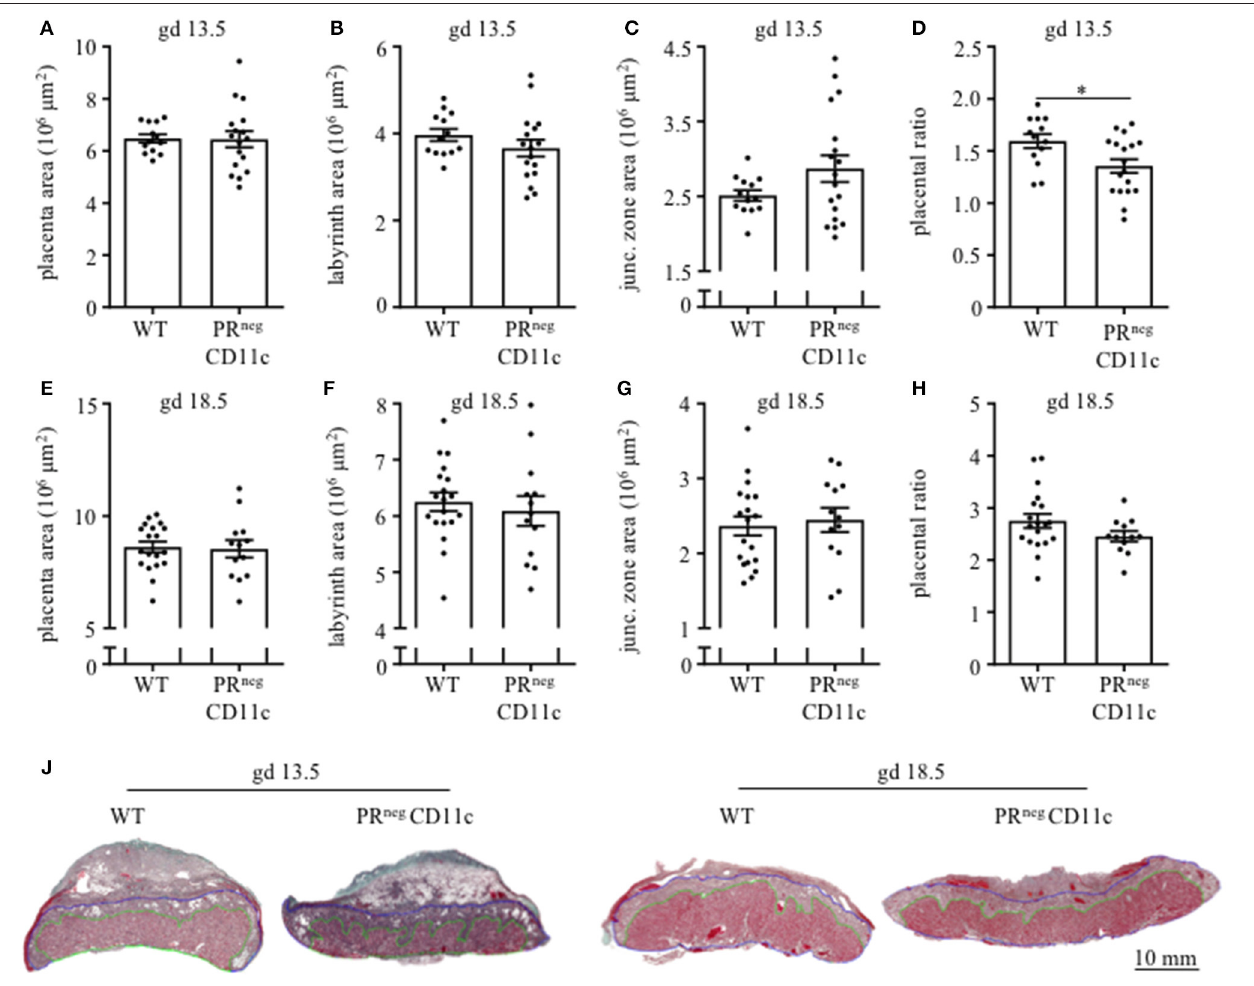
FIGURE 4 | Impaired progesterone-responsiveness of CD11c + dendritic cells affects placental morphology: WT and PR neg CD11c female mice were allogenically mated and placentas harvested on gestation day (gd) 13.5 und 18.5 were evaluated by Masson-Goldner trichrome staining allowing the differentiation of the labyrinth and junctional zone. (A,E) show total placenta area on gd 13.5 and 18.5, respectively. Area of the labyrinth (B,F) and the junctional zone (C,G) have been assessed and the placental ratio (D,H) was calculated. (J) Representative photomicrographs illustrating mid-sagittal sections of gd 13.5 and 18.5 placental tissue from WT (left) and PR neg CD11c (right) mothers, black line in the picture denotes 10mm, green lines encircle the labyrinth, blue lines surround the junctional zone. Data are represented as mean ± SEM. * p ≤